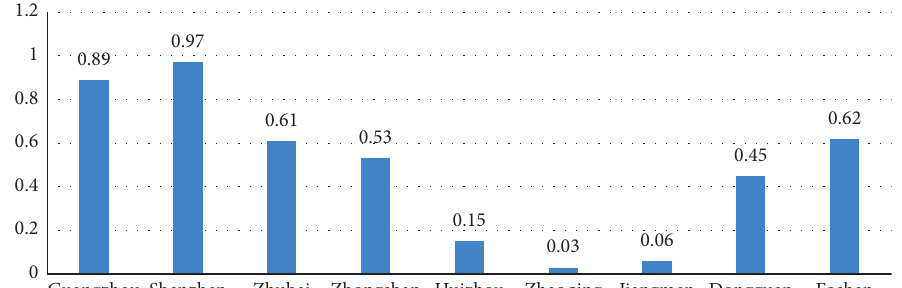
Figure 1: Regional difference map of U